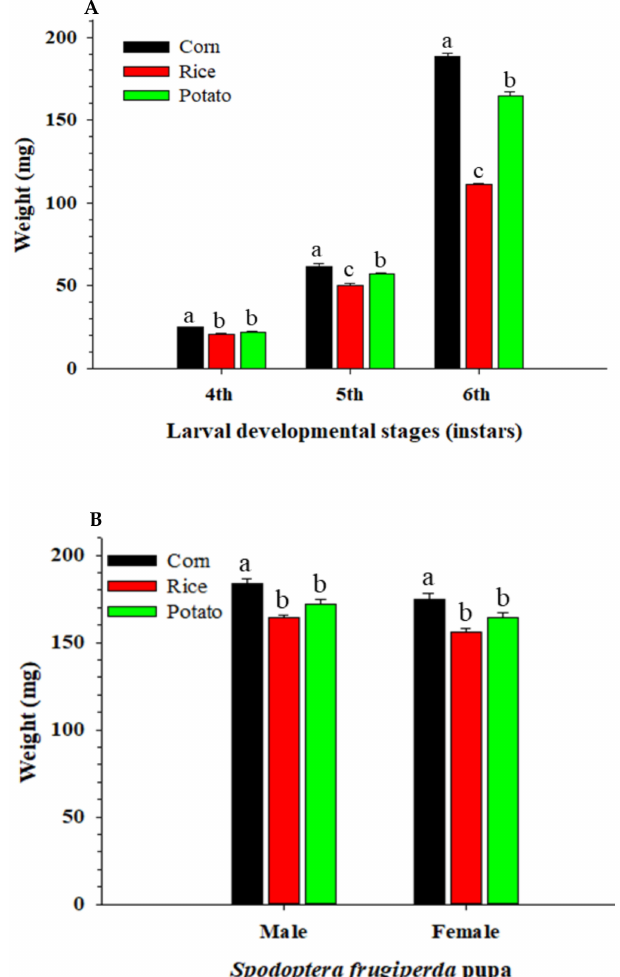
Figure 1. Larval ( A ) and pupal ( B ) weight of Spodoptera frugiperda fed on corn, rice, and potato. Different letters above bars within the same instar stages or sexes denote a significant